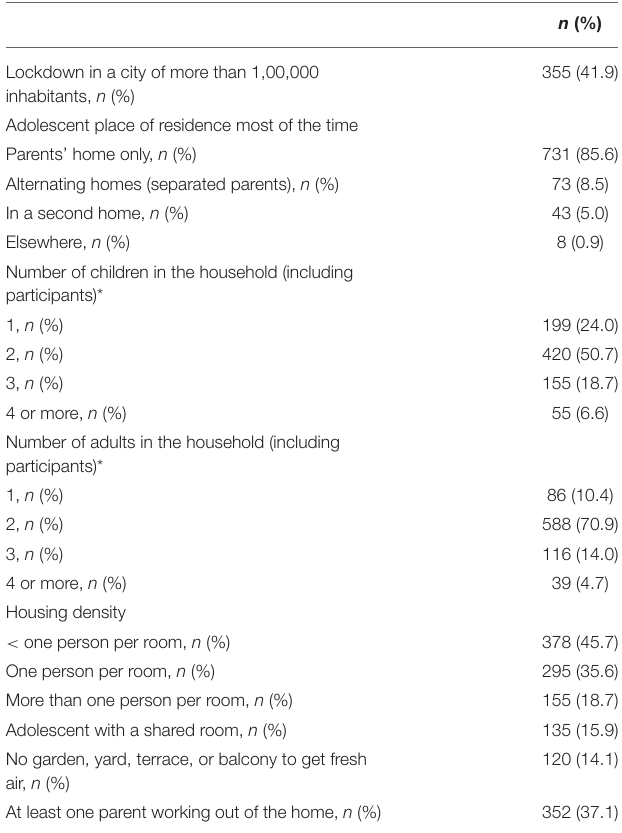
TABLE 1 | Family and home characteristics of the PARIS birth cohort during the